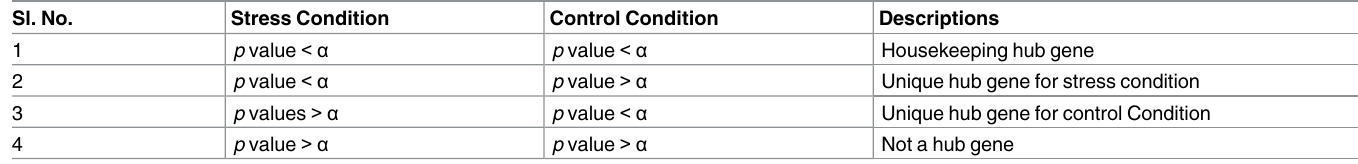
Table 2. Decision matrix for differential hub gene